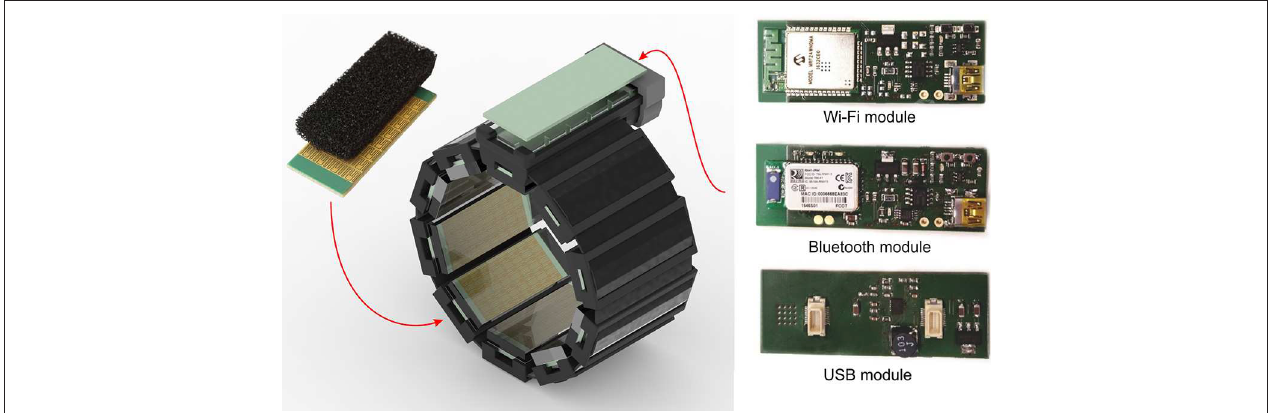
the forearm, measures the bulges of the muscles with a spatial resolution of 5 mm. Depending on the thickness of the arm, up to ten sensor modules, with 4 × 8 tactile cells each, can be used. The modular design and the attachment around the arm using hook-and-loop band allow the bracelet to conform on various arm sizes and shapes, the latter especially important in case of residual limbs. The data from up to 320 tactile cells is sampled at 100 Hz.